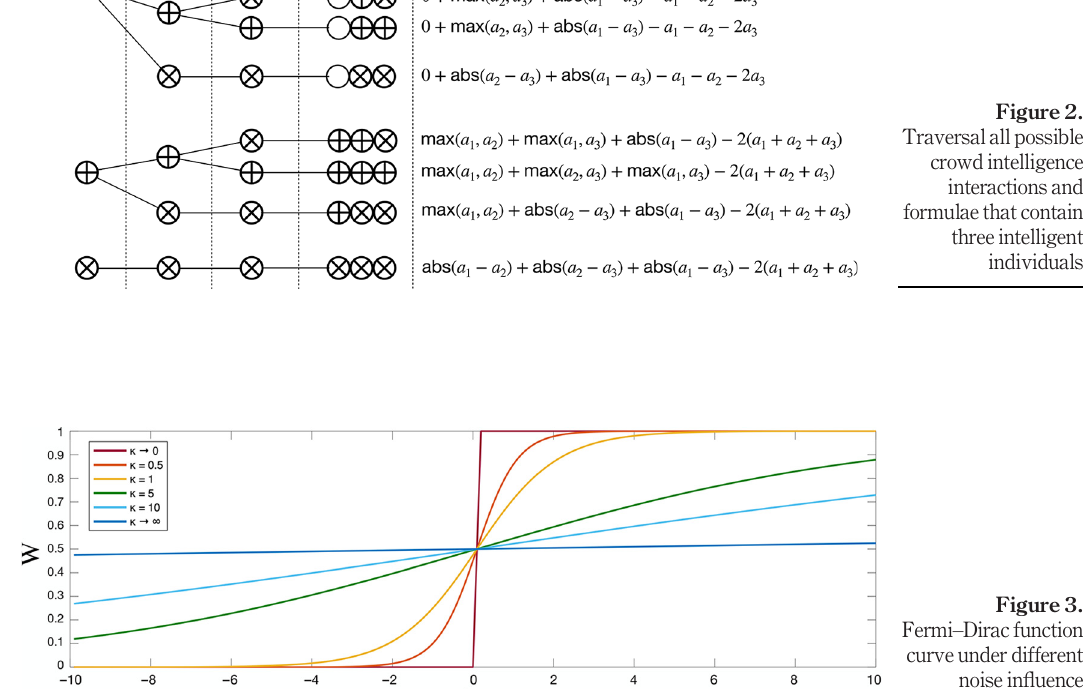
Figure 3. Fermi – Dirac function curve under different noise in fl